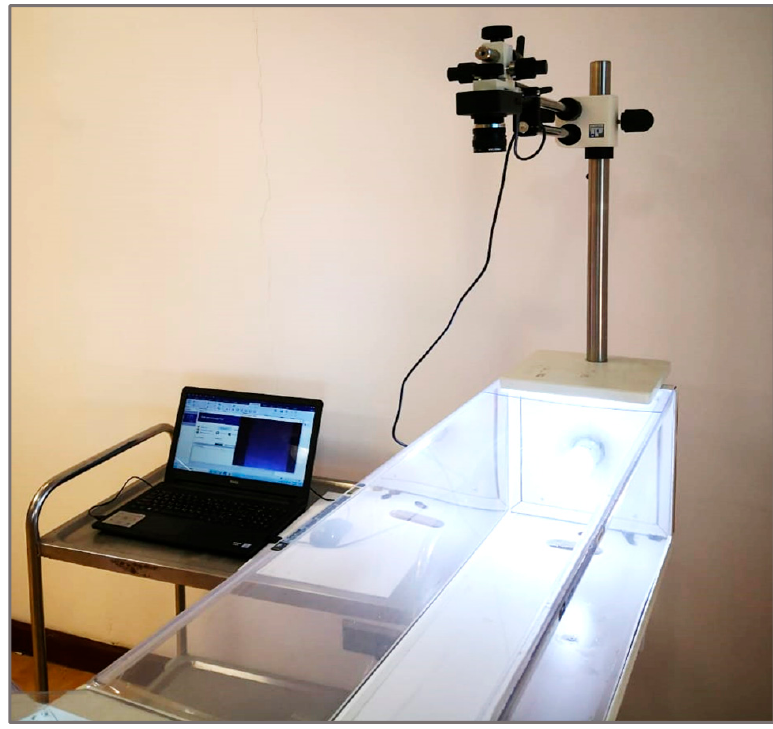
Figure 12. Image of the computerized flight-tunnel with the image processing system.